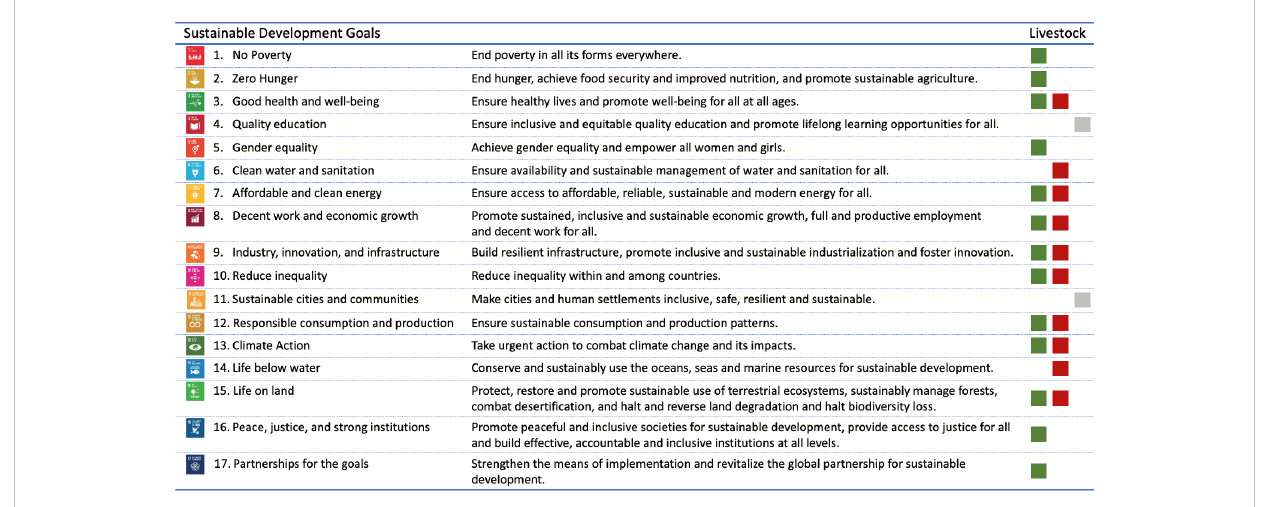
FIGURE 1 The 17 Sustainable Development Goals and the contribution of livestock categorized as opportunity ( ◼ ), challenge ( ◼ ) or neutral ( ◼ ) as per FAO